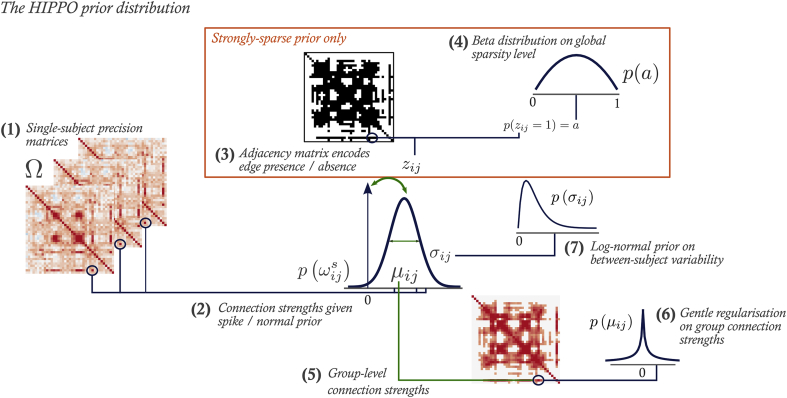
Hierarchical prior on precision matrices. A spike and non-central slab prior (2) is placed on each off-diagonal element of the precision matrices (1). In the strongly sparse version of the prior, selection of the slab or spike (presence or absence of a network connection) is controlled by an adjacency matrix (3), with a learnt sparsity level (4). In the weakly sparse model, this feature is not used and only the slab imposed as a prior on connection strengths. The slab is modelled as a normal distribution describing the mean (5) and variance over connection strengths. The mean is regularised by a sparsity-inducing prior (6), and the variance by a weakly informative log-normal prior (7). We call this model and its inference scheme Hierarchical Inference of Posterior Precisions in OSL (HIPPO).